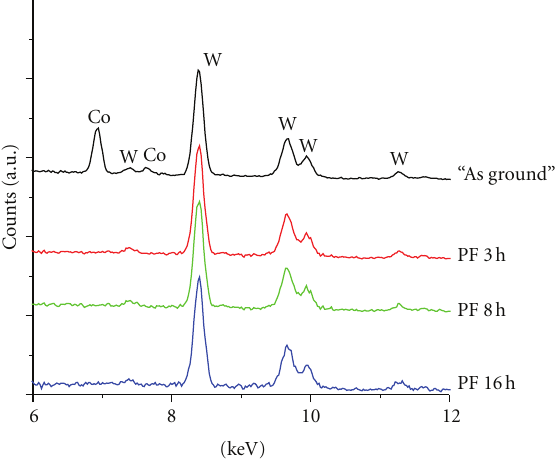
Figure 2: EDS after etching with Caro’s acid and 3h long FB